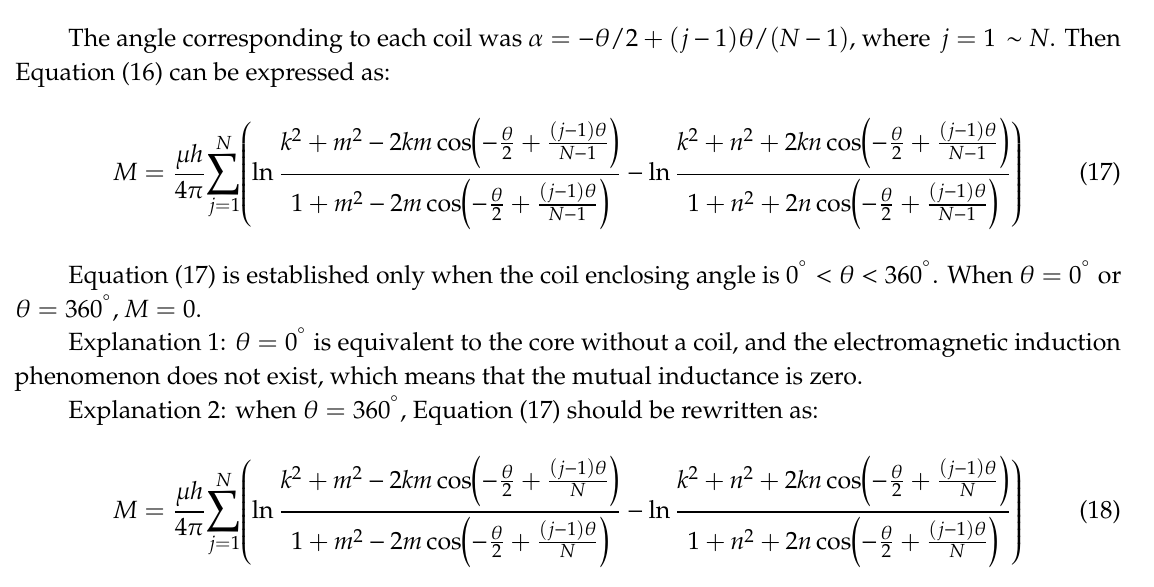
Figure 7. Analysis of the sensor coil’s distribution.